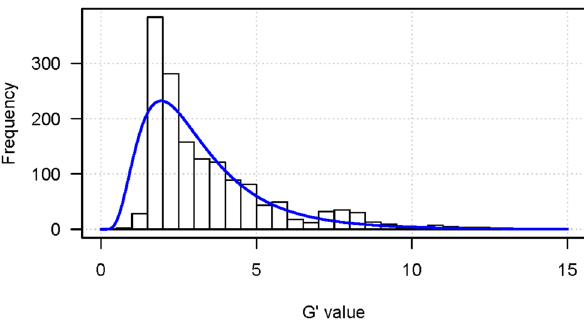
Figure 2. Frequency histogram and estimated null distribution of G 9 values. The G 9 values were sampled by randomly selecting one every 200 kb from the whole genome excluding the five major G 9 peak